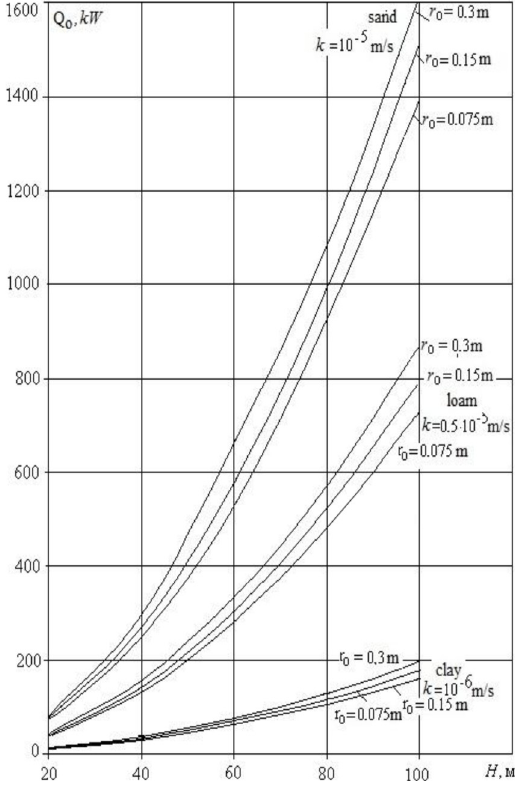
Fig. 3. Heat power of the